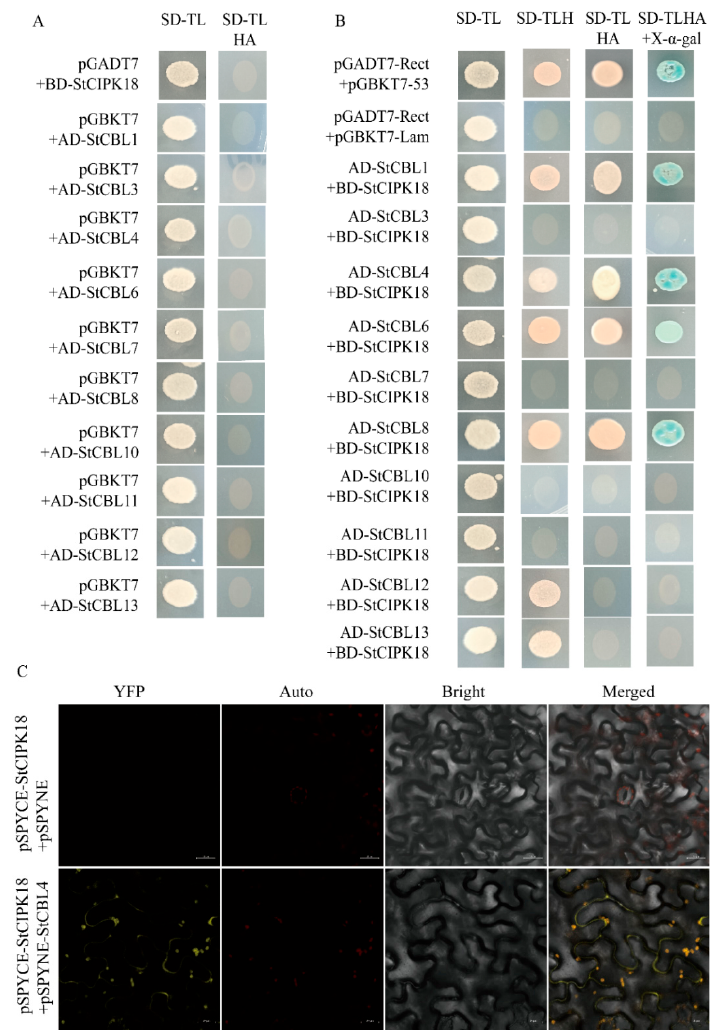
Figure 3. Interaction between StCIPK18 and StCBLs, demonstrated by yeast two-hybrid assay and BiFC. ( A ) Self-activation experiment of StCIPK18 and StCBLs. ( B ) Y2H assay analyzing the interac- tion between StCIPK18 (bait) and StCBLs (prey). ( C ) BiFC assay of the interaction between StCIPK18 and StCBL4. StCIPK18 was introduced into the pSPYCE vector and fused with C-terminal YFP; StCBL4 was introduced into the pSPYNE vector and fused with N-terminal YFP. pSPYCE-StCIPK18 + pSPYNE was used as a negative control. The scale bale represents 20 μ m. 2.4. Genetic Transformation of StCIPK18 Gene in Potatoes and Identification of Transgenic Plants